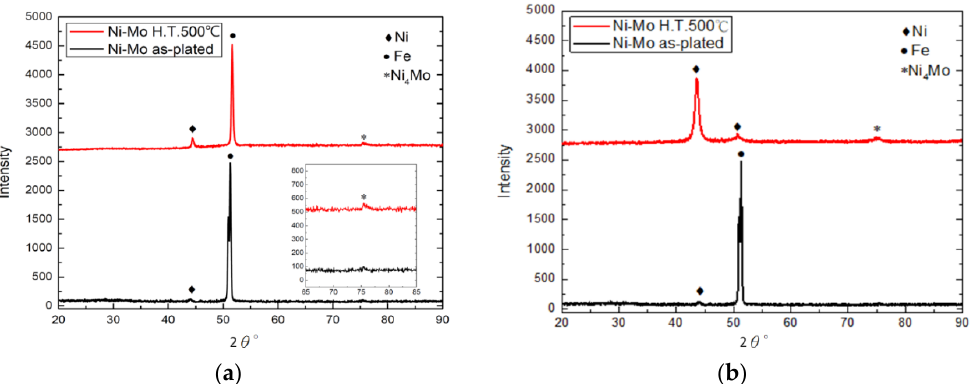
Figure 10. XRD patterns of worn surfaces on Ni–Mo and annealed Ni–Mo coatings: ( a ) Ni–Mo wear region; ( b ) annealed Ni–Mo wear region.